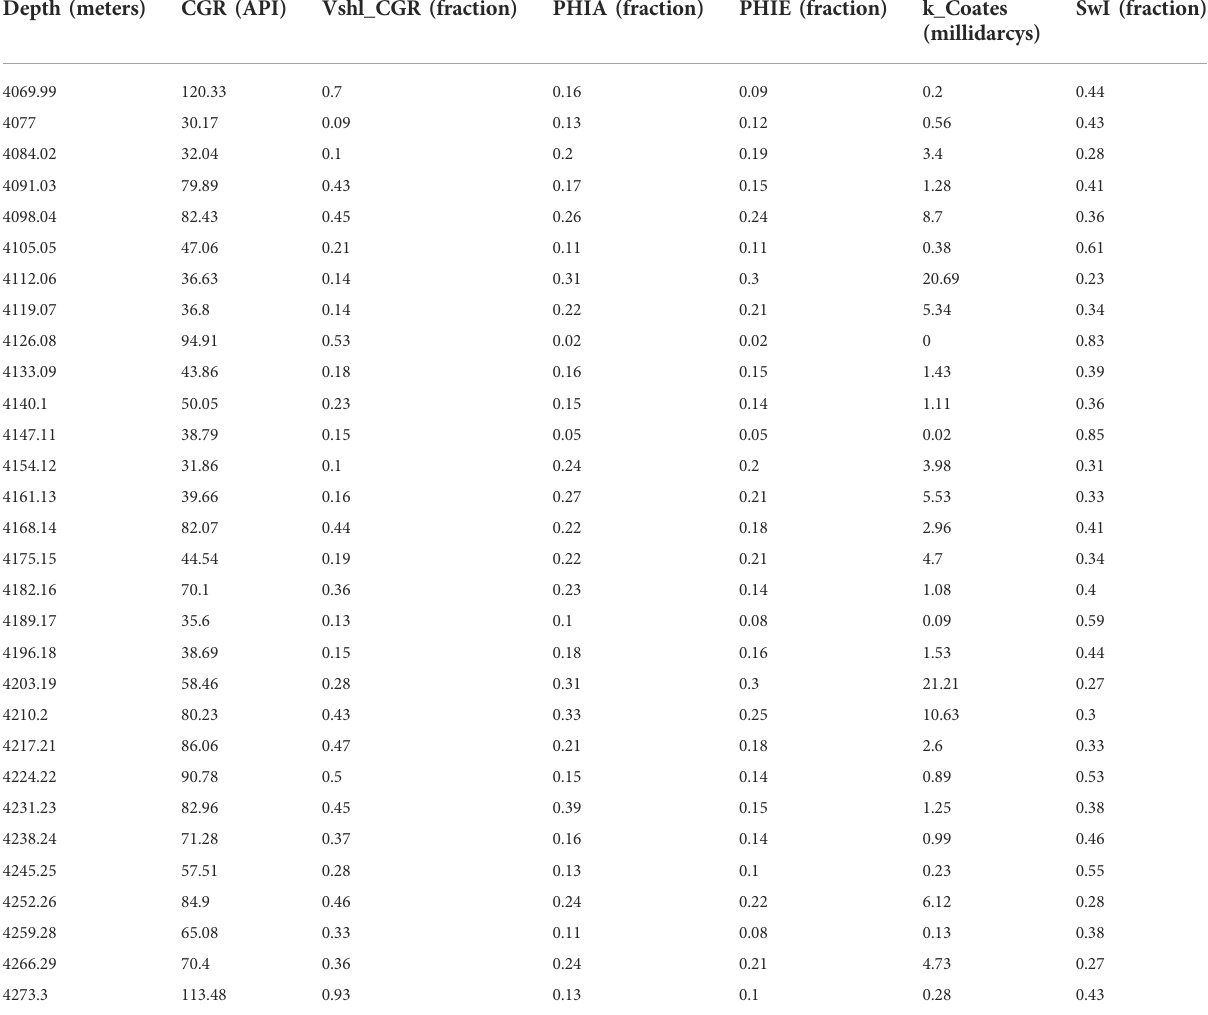
TABLE 2 Quantitative analysis of the petrophysical properties computed in the Sembar Formation sands. Depth